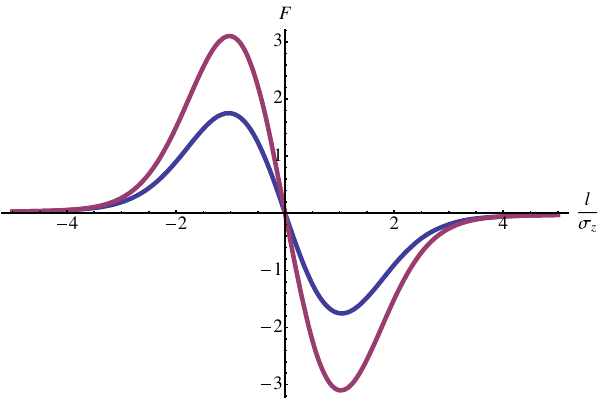
FIG. 6. Plot of the F function for two R= σ Table 1 versus l= σ . Blue is for the CeC PoP case; magenta is for z eRHIC